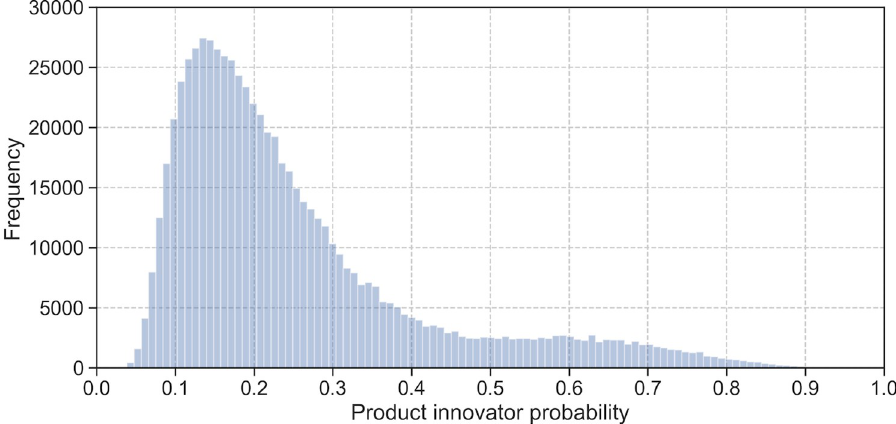
Fig 2. Product innovator probabilities distribution. Histogram of predicted product innovator probabilities for 685,057 firms.